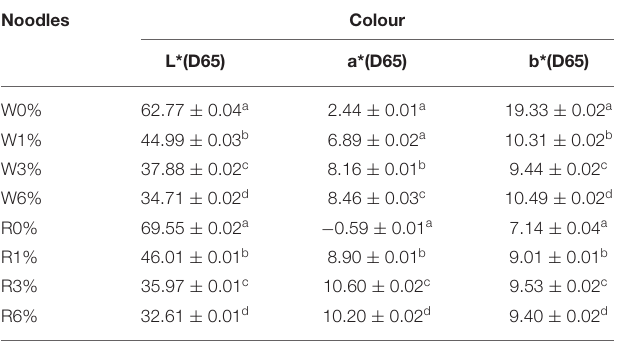
TABLE 3 | Colour properties of cooked rice and wheat noodles incorporated with EA extract. Noodles FIGURE 6 | Colour swatches for cooked (A) Wheat and (B) Rice noodles